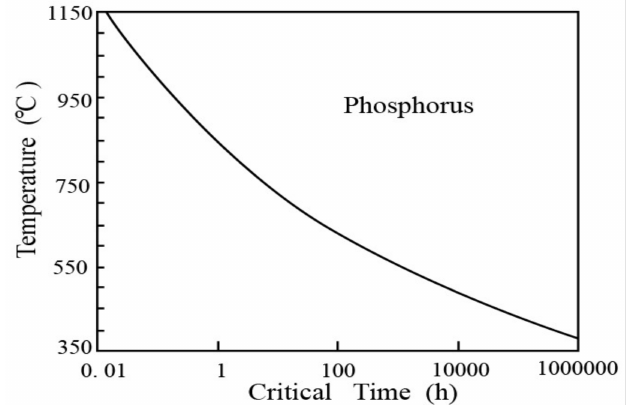
Figure 18. A schematic diagram showing the relationship between critical time and deformation temperature, simulated with Equation (1) for phosphorus in steel. Reprinted with permission from ref. [27]. Copyright 2004